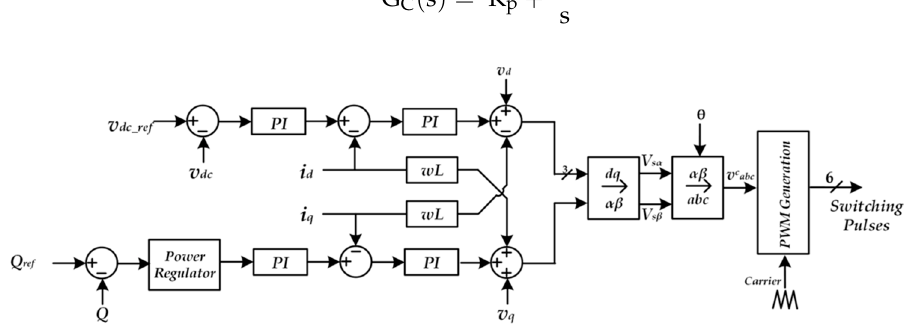
Figure 24. Proportional-Integral (PI) Control Strategy with dual control loop.